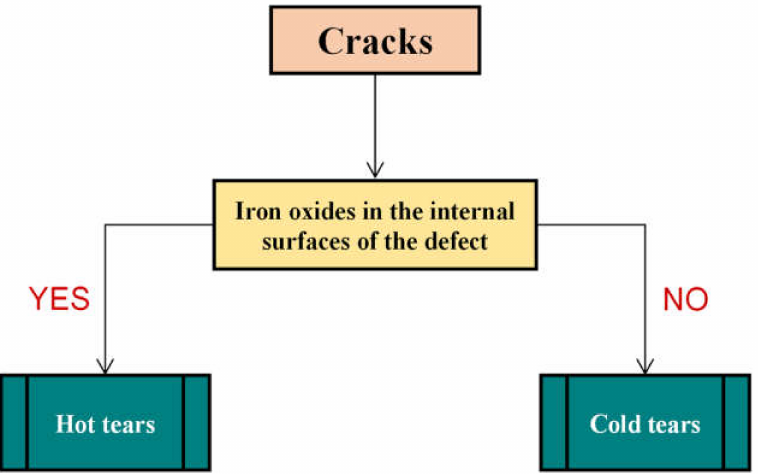
Figure 60. Classification of tearing in castings according to the characteristics of internal surfaces in